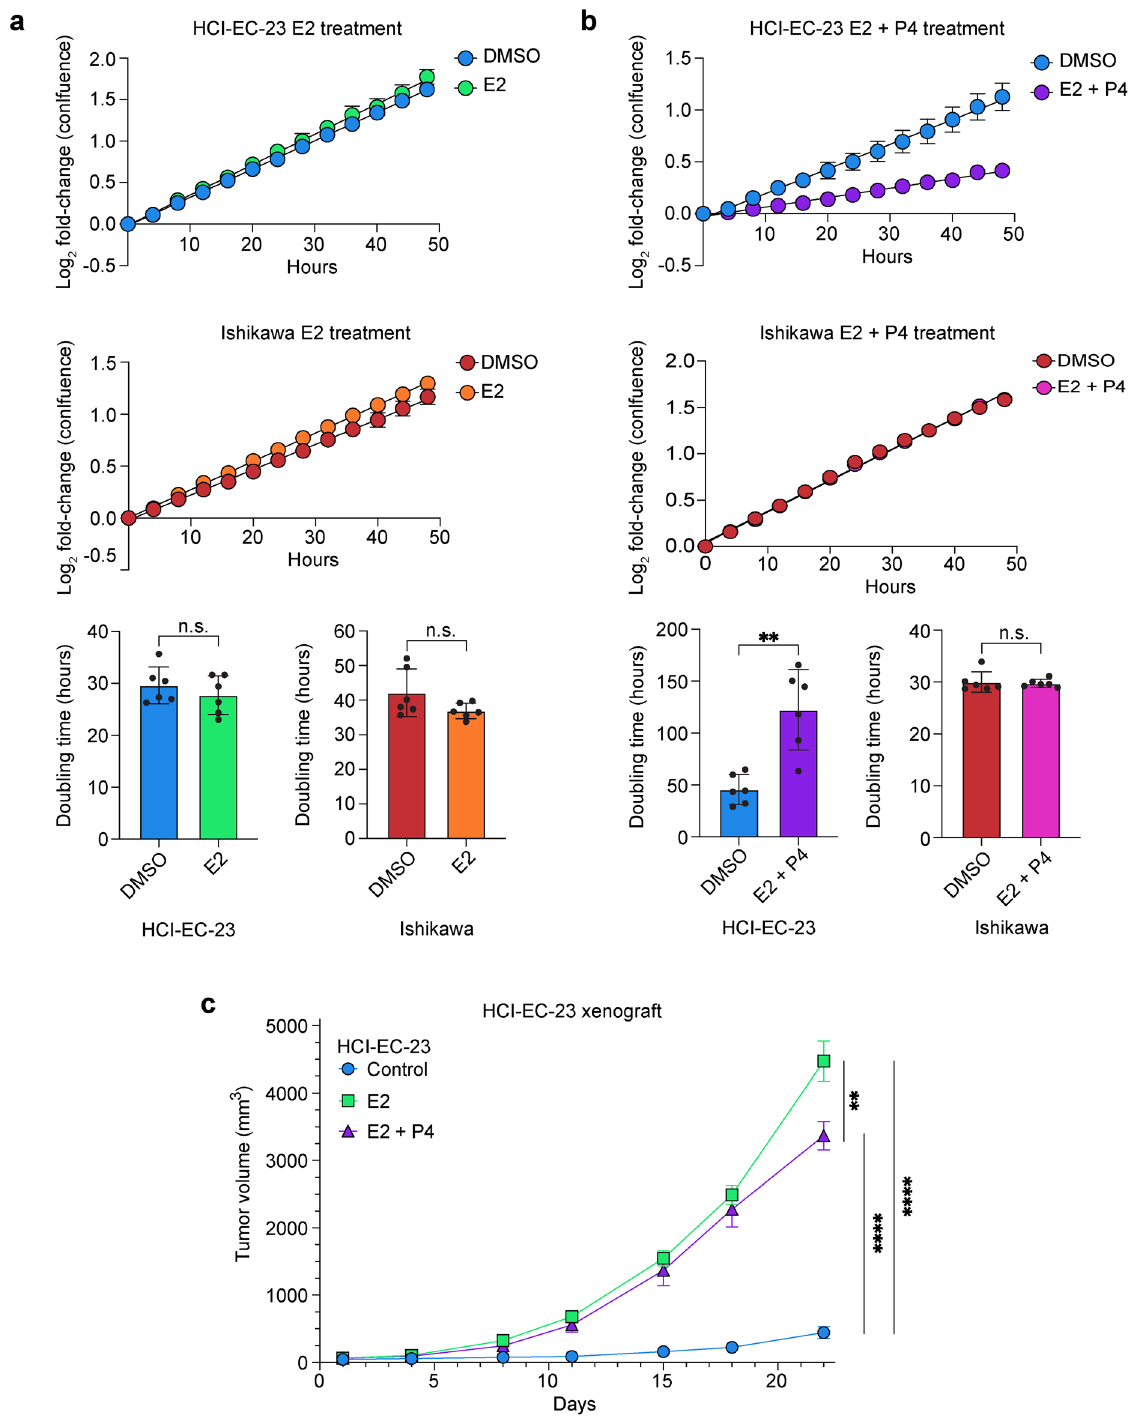
Figure 3. Growth characteristics of HCI-EC-23 in vitro and in vivo. (a) In vitro log 2 growth curves of HCI-EC-23 (top) and Ishikawa (middle) treated with DMSO or 10 nM E2 demonstrate no significant change in growth rate upon E2 stimulation in both cell lines. Bar plots of doubling times were calculated from these curves and shown for HCI-EC-23 (bottom left) and Ishikawa (bottom right). Data are shown as the mean of six replicates of each cell line. Line graph error bars represent standard error of the mean and barplot error bars represent standard deviation. (b) In vitro log 2 growth curves are shown for HCI-EC-23 (top) and Ishikawa (middle) treated with DMSO or 10 nM E2 + 100 nM P4. The addition of P4 results in significant arrest of proliferation in HCI-EC-23. Bar plots of doubling times were calculated from these curves and shown for HCI-EC-23 (bottom left) and Ishikawa (bottom right). Line graph error bars represent standard error of the mean and barplot error bars represent standard deviation. (c) Line graph of in vivo tumor growth is shown for HCI-EC-23 xenografts in ovariectomized, immunocompromised mice. 1 × 10^6 cells were injected into the flank of mice treated with E2 (n = 4), E2 + P4 (n = 5), or control (n = 5) pellets. Day 1 represents the first day of measurement and was 10 days post- injection. Error bars represent standard error of the mean. *p < 0.05, **p < 0.01, ***p < 0.001, ****p < 0.0001, n.s. not